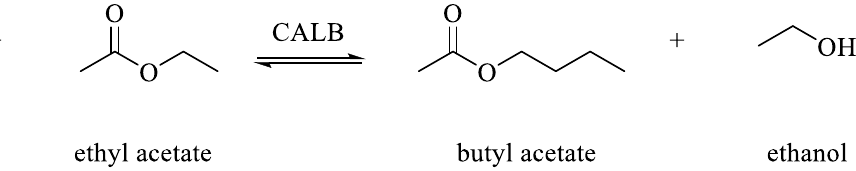
Figure 8. The reaction diagram of butyl acetate synthesis catalyzed by CALB.